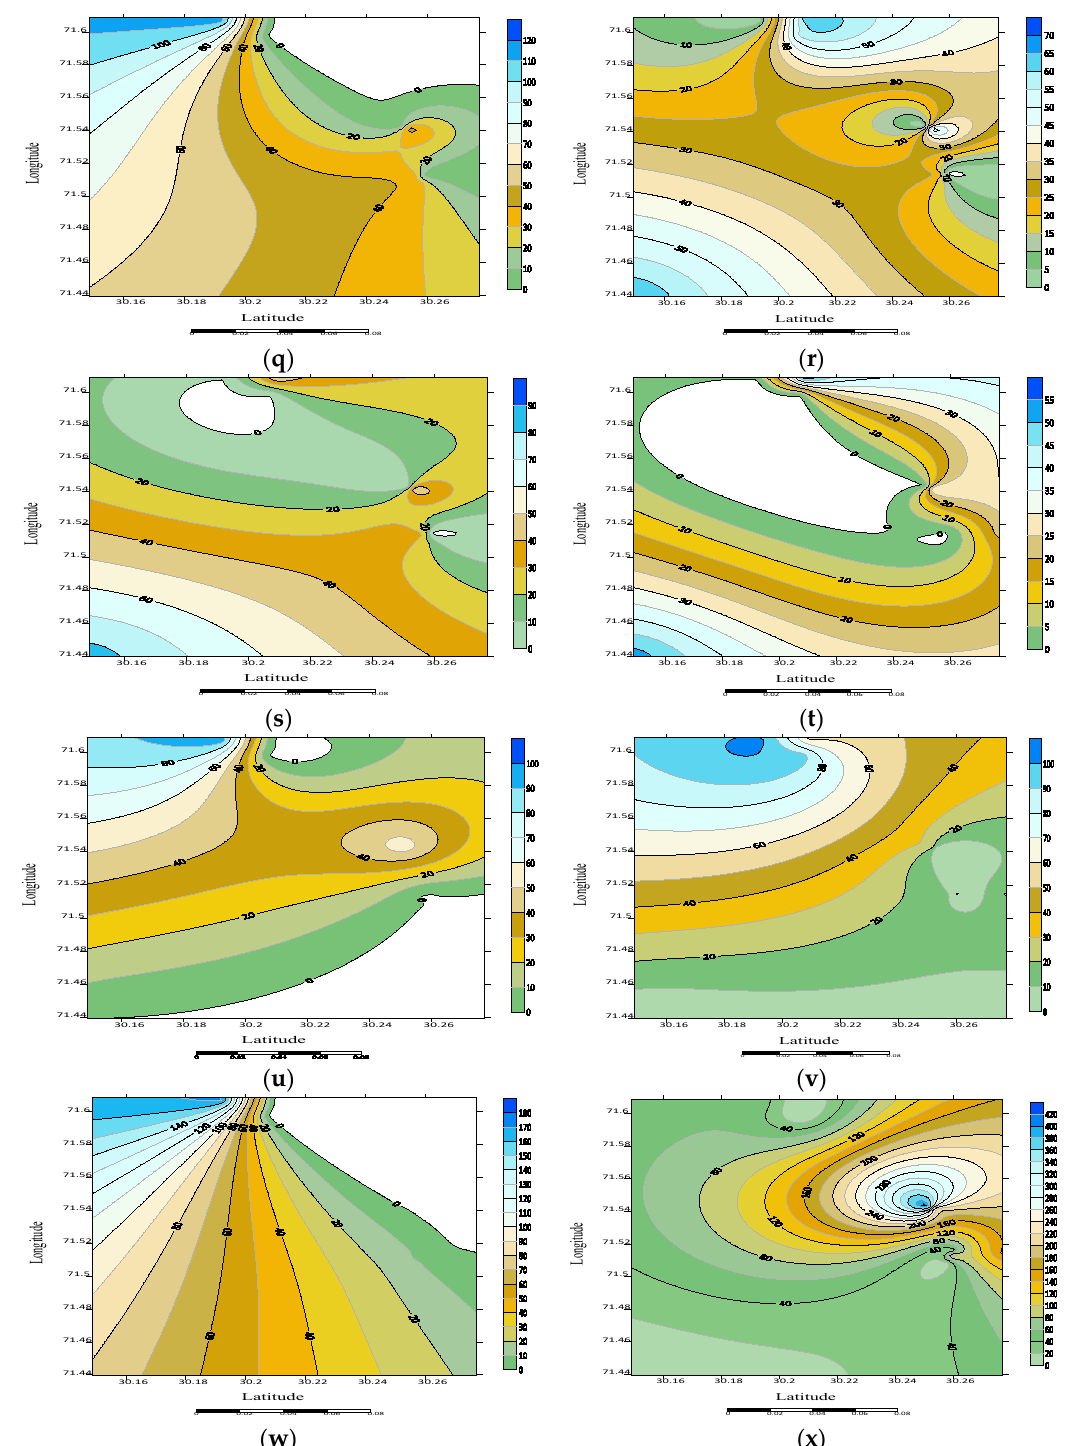
Figure 3. Spatial contour maps of H. stigmosa ( a ), H. tripoli ( b ), H. Jahangiri ( c ), S. litura ( d ), S. exigua ( e ), H. armigera ( f ), H. platigera ( g ), C. placodoides ( h ), C. repleta ( i ), A. ipsilon ( j ), A. cinerea ( k ), A. album ( l ), A. decisissima ( m ), E. insulana ( n ), E. vitella ( o ), C. furthatai ( p ), L. oleracea ( q ), E. conducta ( r ), L. venalba ( s ), D. hoenei ( t ), C. albostriata ( u ), M. loreyi ( v ), M. brassicae ( w ), and S. furgiperda ( x ).